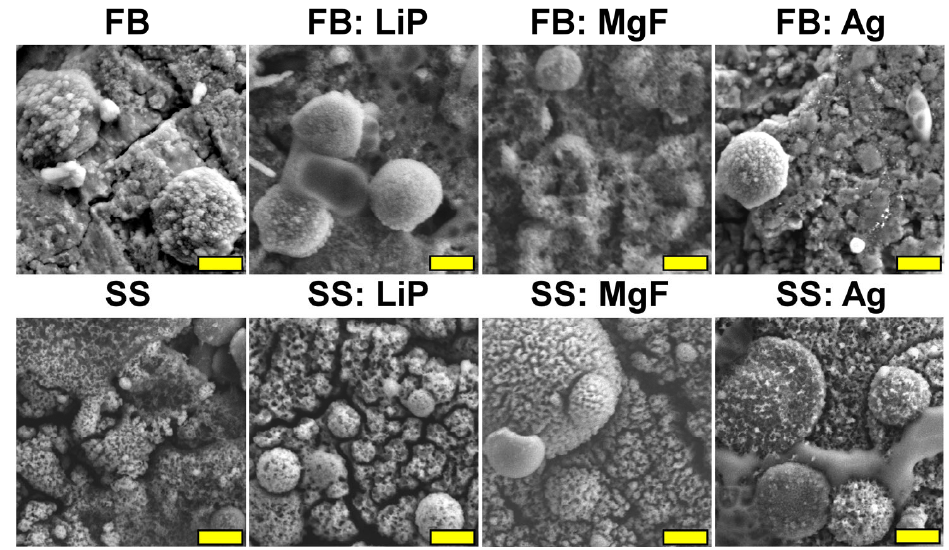
Figure 9. SEM images of the simple and doped FB- and SS-based thin fi lms immersed in SBF for 30 days. Magni fi cation bar: 500 nm.